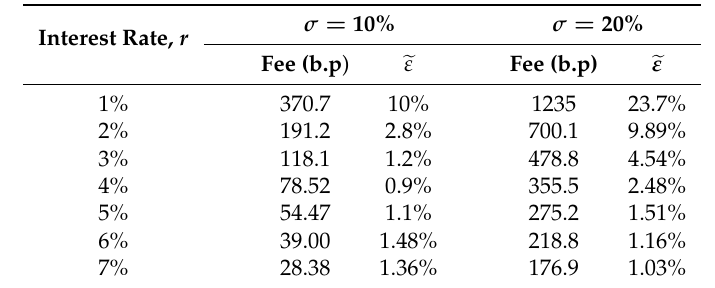
Table 3. Fair fee α in bp (1 bp = 0.01%) as a function of interest rate r for the GMAB on a super account when withdrawals are optimal. The contract maturity is T = 10 years. (cid:101) ε is the percentage difference between the fair fee in the case optimal withdrawal and the fair fee in the static case (no withdrawal) from Table